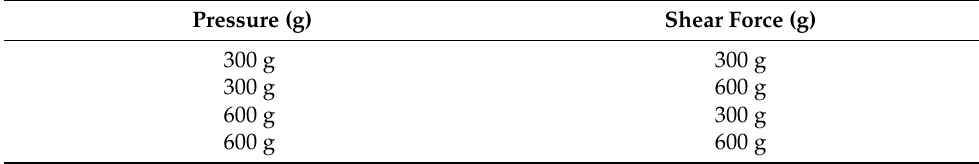
Figure 6. Pressing positions (P1–P4) and directions of shear-force directions (a–d). Table 1. Combinations of pressing pressure and shear